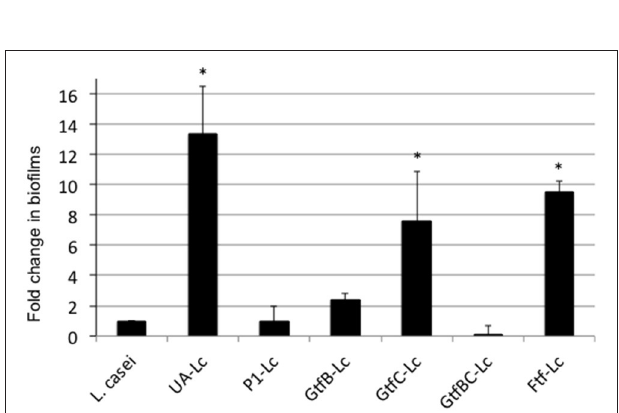
FIGURE 1 | Forty eight-hour biofilms of L. gasseri (Lg), L. fermentum (Lf), L. salivarius (Ls) and L. rhamnosus (Lr) in mono-species and dual-species with S. mutans (Sm) grown in BM plus glucose (18mM) and sucrose (2mM) on glass slides vertically deposited in 50ml Falcon tubes. Data represent the average ( ± standard deviation in error bars) of at least three separate experiments, with * and # indicating statistical difference at P < 0.001 and 0.05, respectively, when compared to the respective mono-species biofilms.